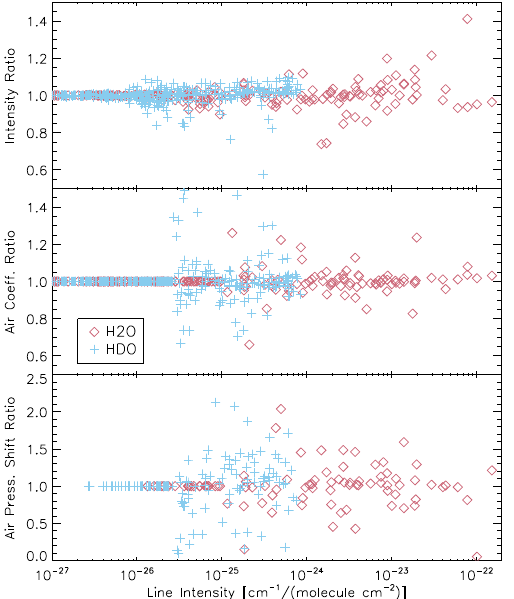
Fig. 3. Ratio of the updated line parameters over the original line pa- rameters. Top: line intensities. Middle: air broadening coefficients. Bottom: air pressure